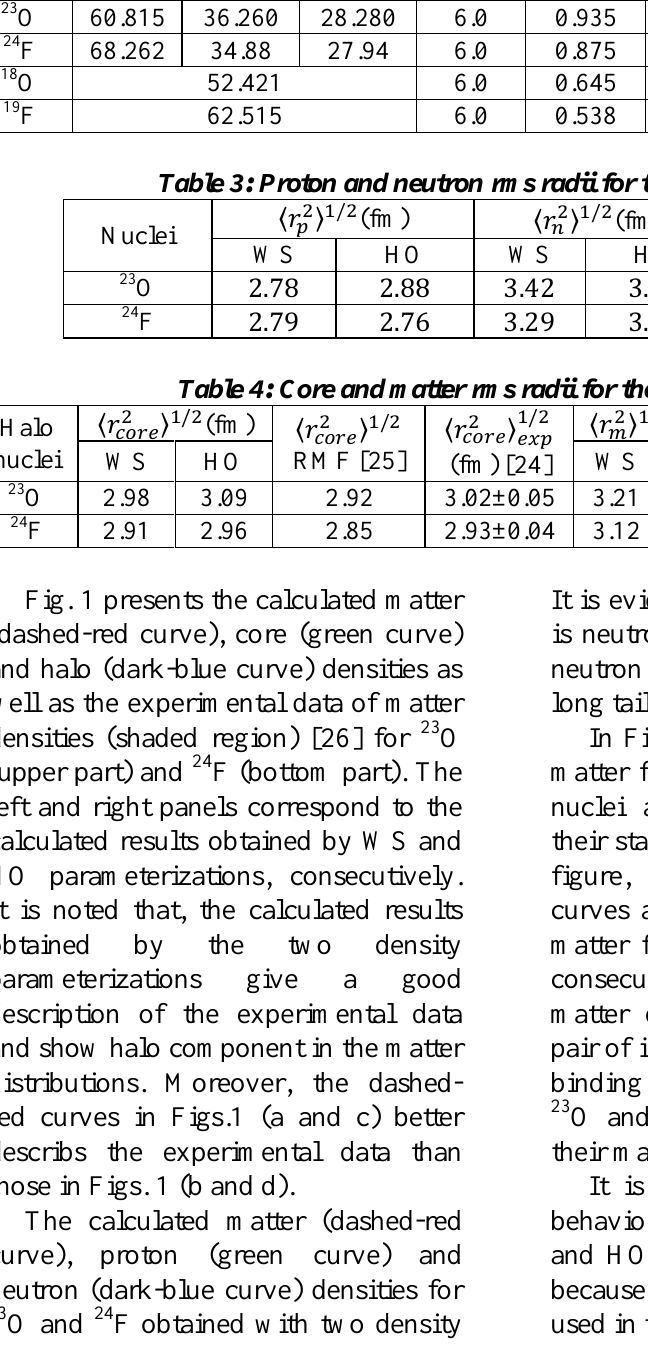
Table 2: Parameters of the WS and HO parametrizations used in the present analysis. Nuclei